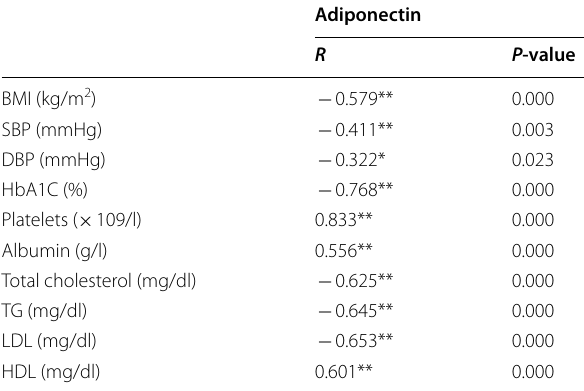
P -value > 0.05, non-significant; P -value < 0.05, significant; P -value < 0.01, highly significant Spearman correlation coefficient